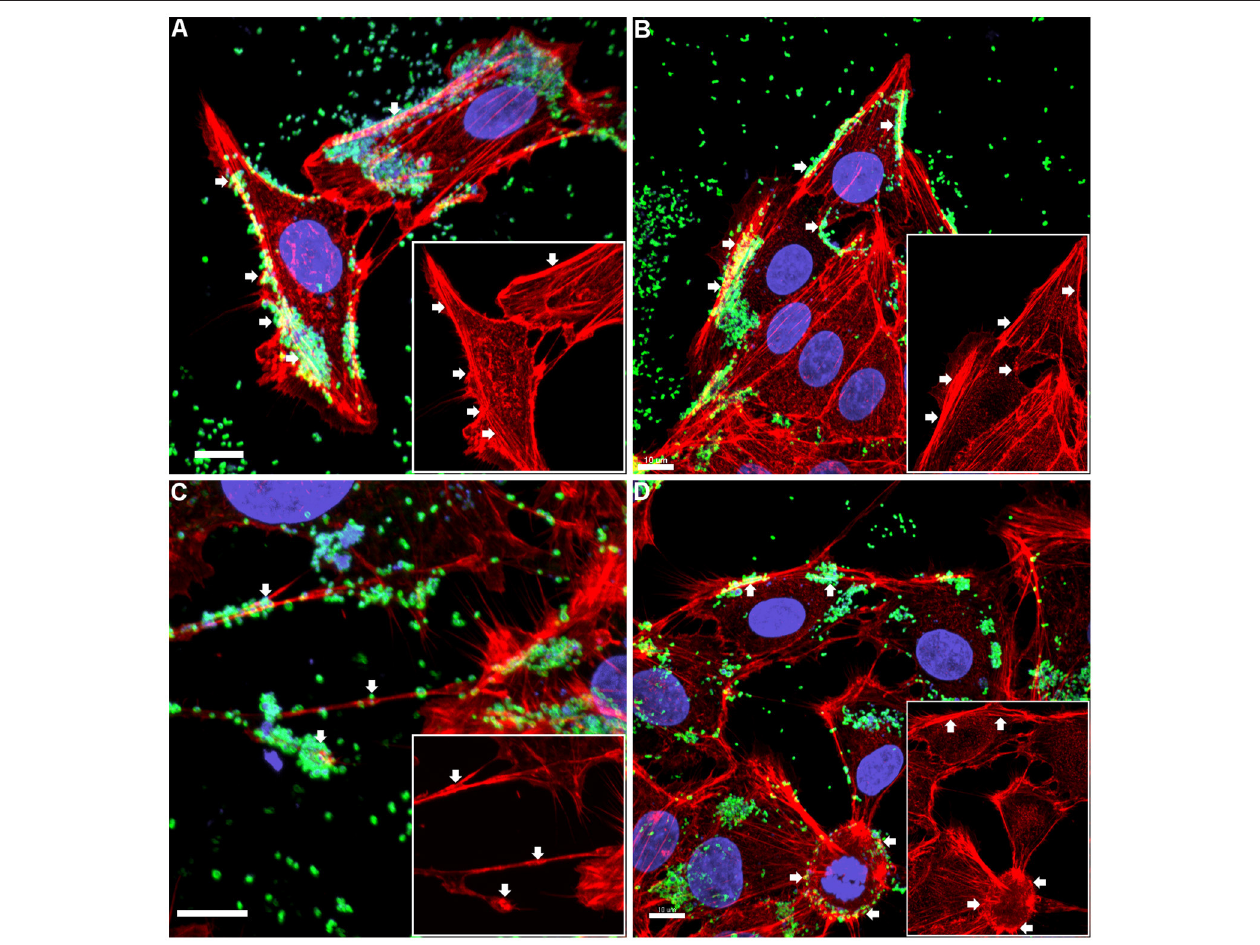
FIGURE 1 | Confocal micrograph overlays of adherence patterns of M. hyopneumoniae cells to PK-15 monolayers. M. hyopneumoniae cells were labeled with F2 P94 − J antisera conjugated to CF TM 488 (green), nucleic acids were stained with DAPI (blue), and F-actin was stained using phalloidin (red). M. hyopneumoniae cells can be seen adhering to the edges of the monolayer and to cellular projections that appear to be filopodia (white arrows). Inserts in each panel depict the phalloidin channel of each image (more specifically, the areas highlighted in the overlays), highlighting areas that stain intensely for F-actin (white arrows). (A–D) represents images taken from individual replicate experiments. Scale bars are 10 µ